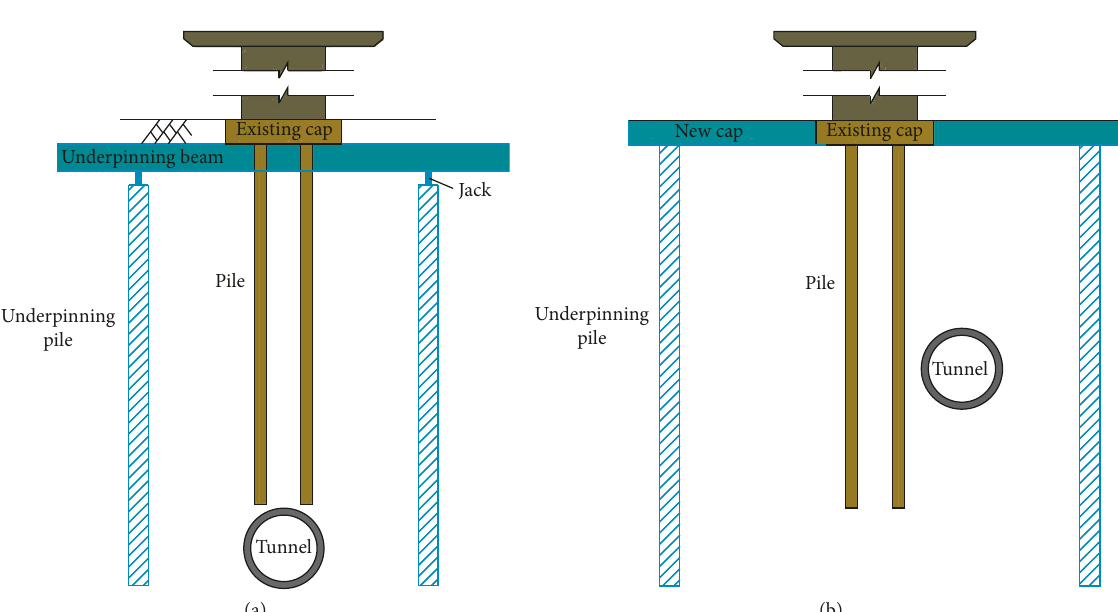
Figure 10: Pile foundation underpinning scheme: (a) active underpinning; (b) passive